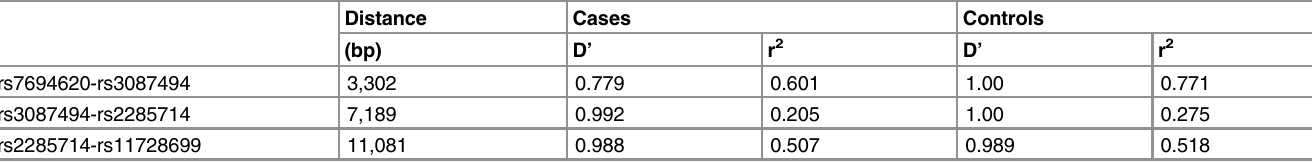
Table 3. Linkage disequilibrium (LD) of SNPs in PLA2G12A .